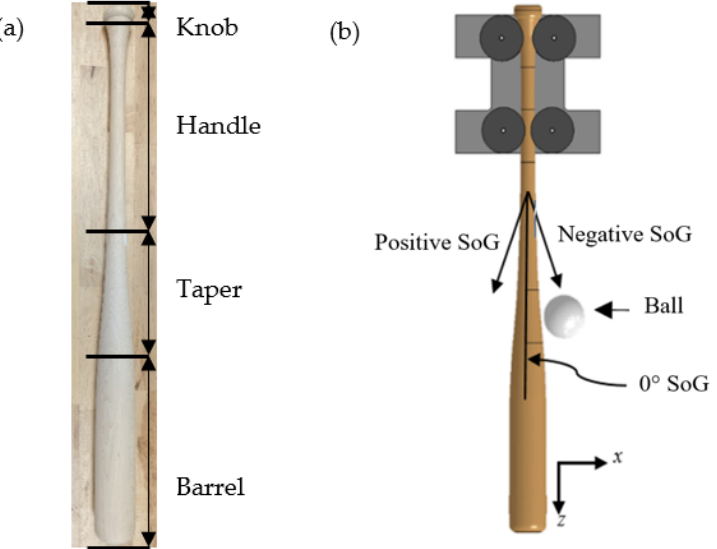
Figure 1. ( a ) Regions of the baseball bat. ( b ) SoG definition of Finite Element Models